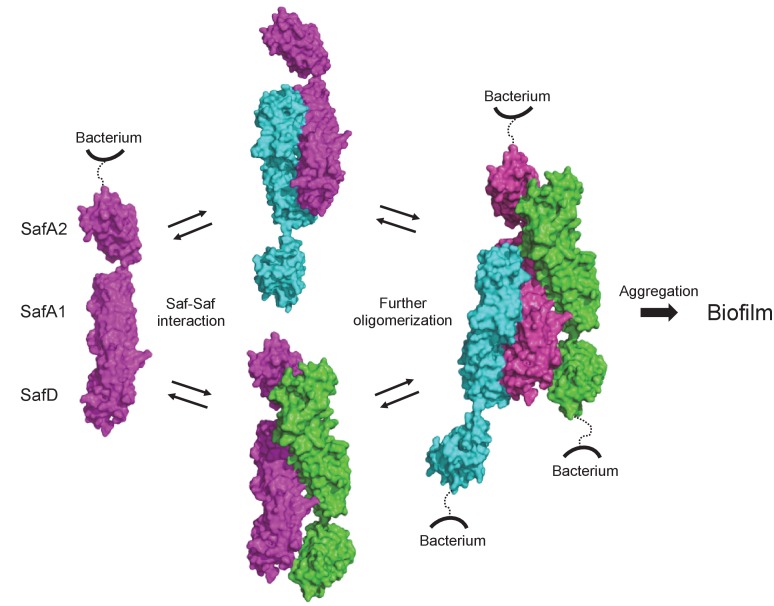
Structural and functional characterization of SafDAA-dsc reveal a novel Saf-driven self-associating mechanism for bacterial aggregation and biofilm formation.In the initial stage, Saf pili can mediate cell-cell interaction via versatile SafDAA dimerizations. As the inter-cellular oligomerization proceeds further, Saf pili might intertwine against each other, enabling a higher order Saf pili oligomerization (n > 3) to generate necessary attractive forces for bacterial aggregation and ultimate biofilm formation.